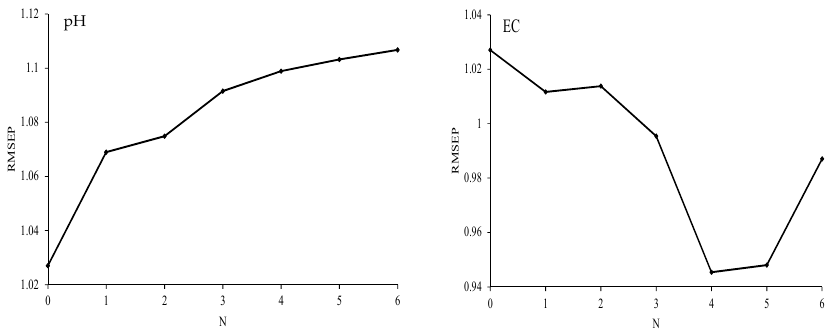
Table 3. Correlation coefficients of each pairwise variable at 38 sites.